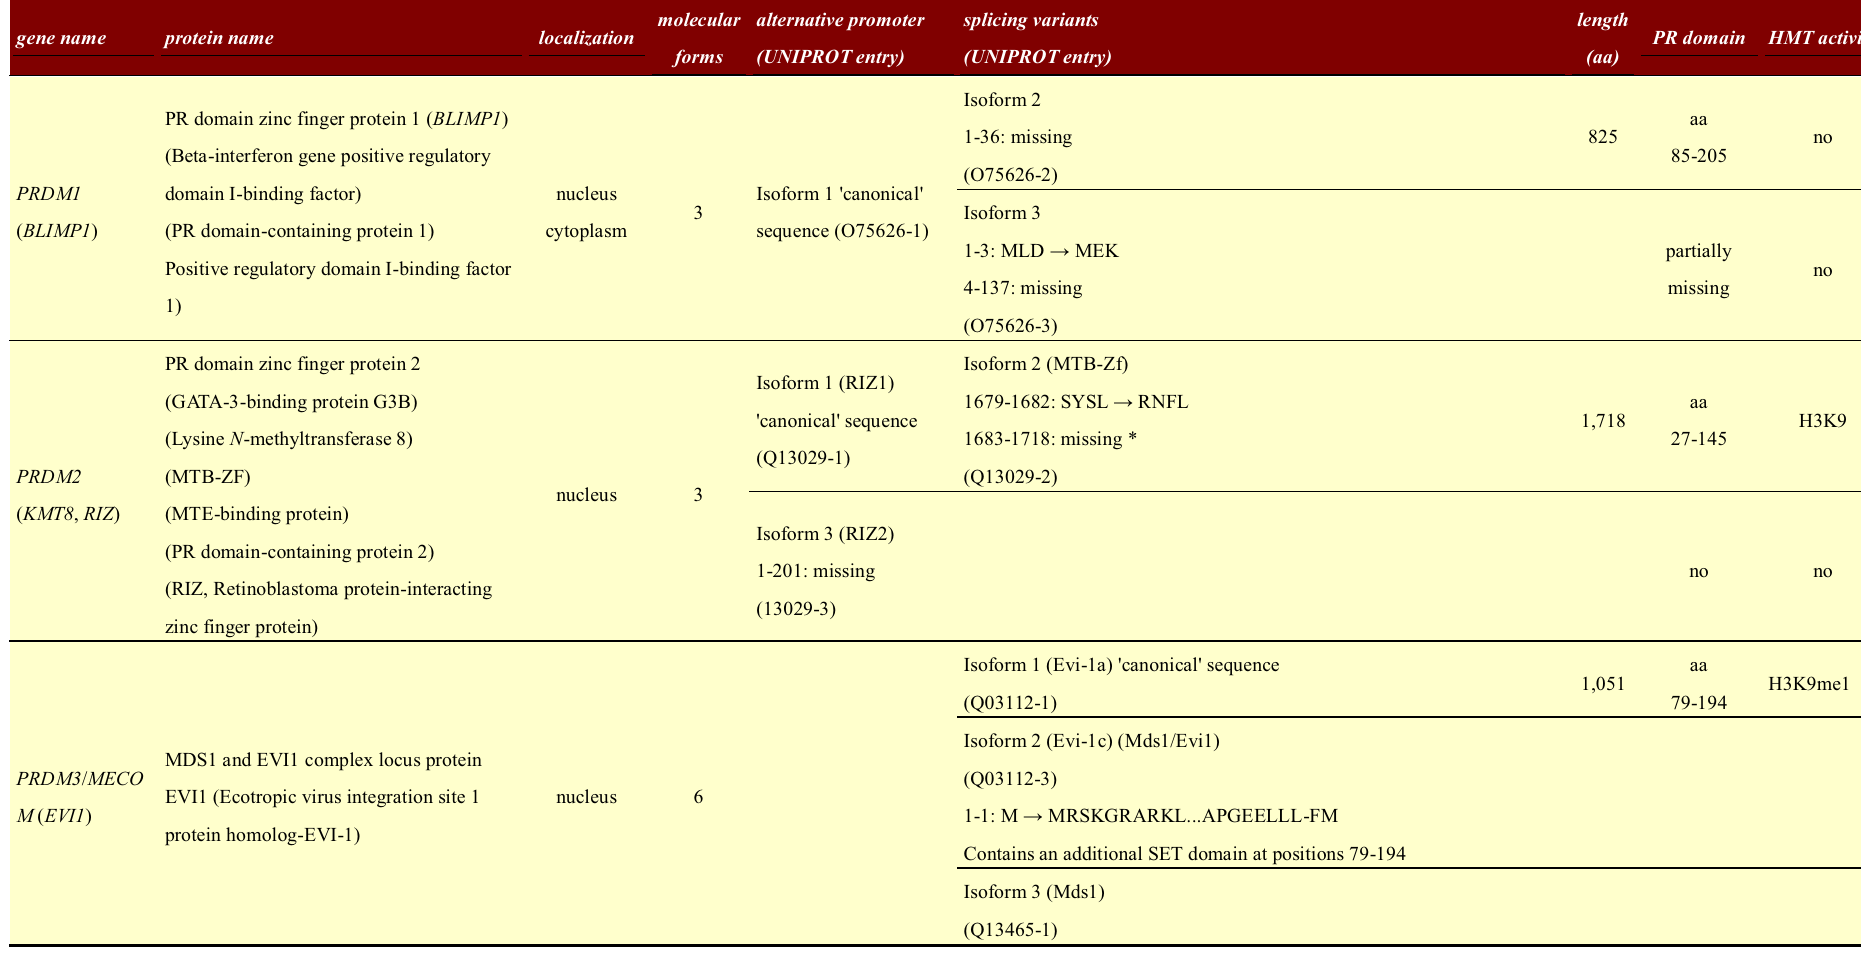
Table 1. PRDM (PRDI-BF1 and RIZ homology domain containing) proteins derived by alternative promoters activity or alternative splicing.